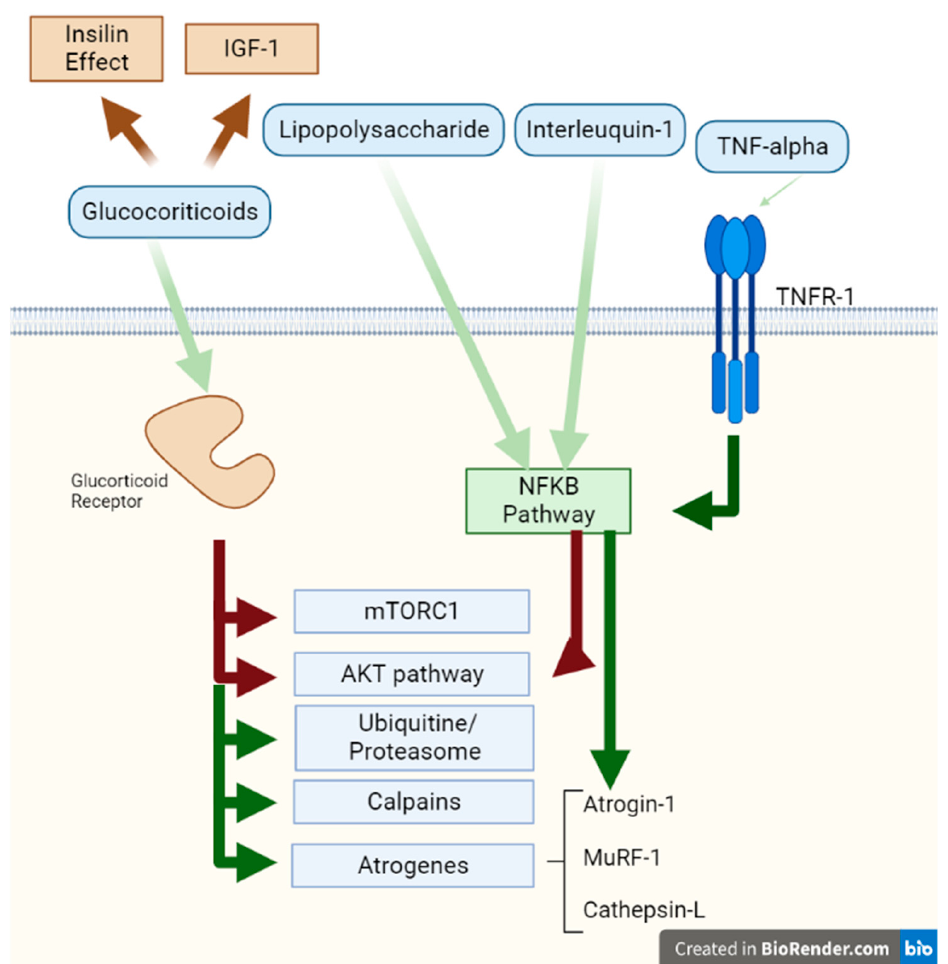
Figure 2. Catabolic effects on muscle. This figure represents the activation effects of the Glucocorticoid Receptor and the TNF receptor 1. The white background represents the extracellular space, the green bar the sarcomere membrane, and the green background the cytosol. Red arrows represent signals with an inhibitory effect and green arrows represent stimulatory effects on different proteins and pathways. Abbreviations: TNF: tumour necrosis factor; TNFR: tumour necrosis factor receptor.